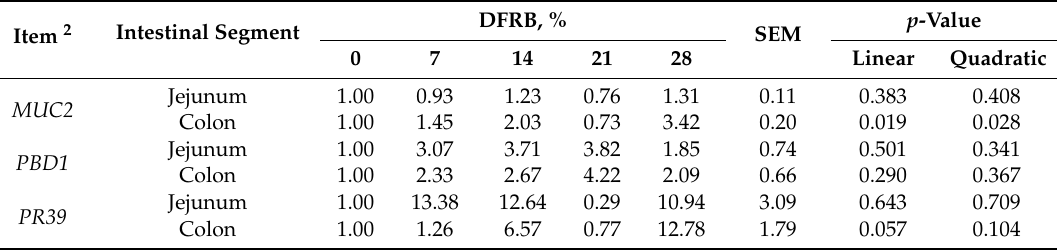
Table 8. E ff ects of increasing DFRB supplementation on MUC2 , PBD1 , and PR39 in jejunum and colon of finishing pigs 1 .